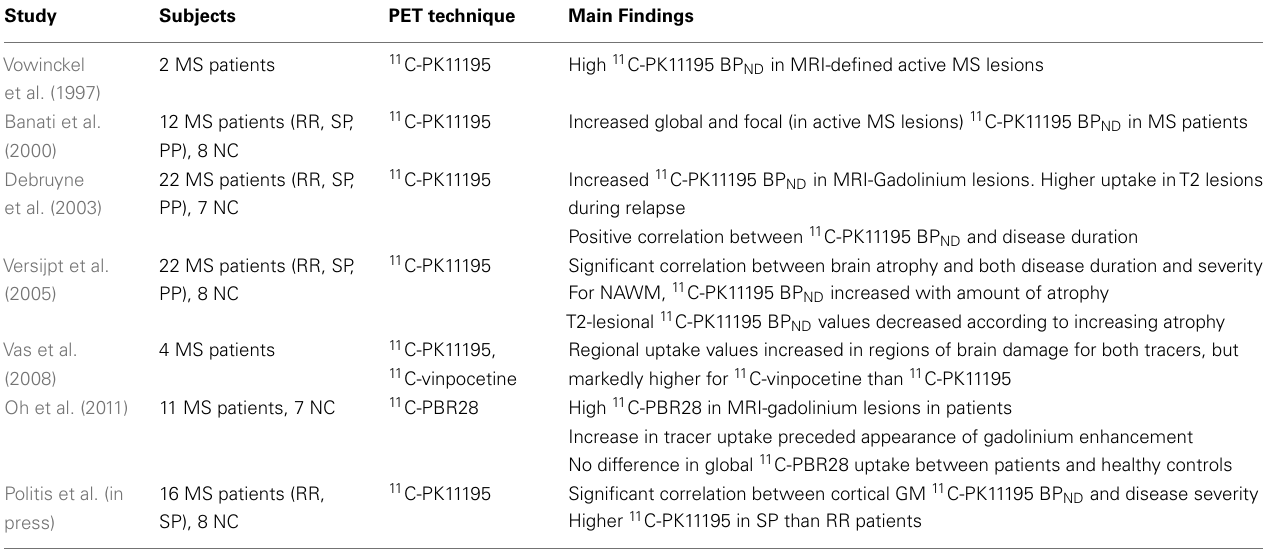
Table 4 | Positron emission tomography imaging studies assessing microglia in multiple sclerosis. Study PET